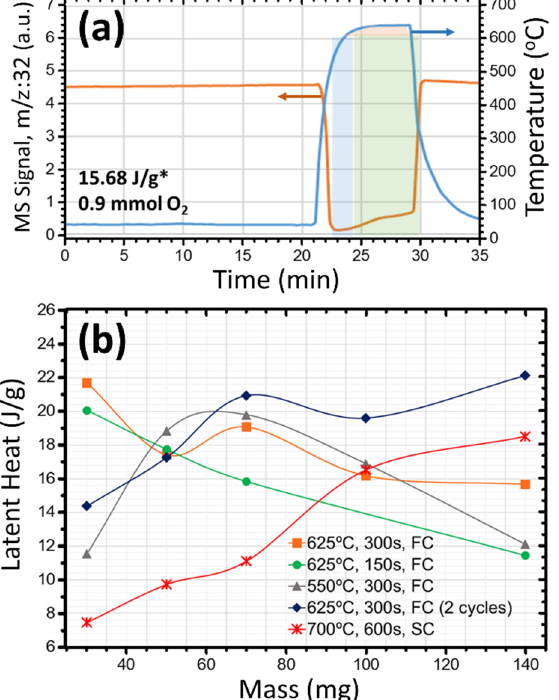
Figure 4. ( a ) TPO-MS for V oxidized at 625 °C for 5 min using ~10 °C s − 1 and ~1 °C s − 1 heating and cooling rates, respectively, the total spent O 2 , and the DSC result for a similar product obtained in open tube. ( b ) Value of enthalpy of MIT (metal to insulator) transformation indicative of the VO 2 yield, for different masses of vanadium subjected to different treatments of oxidation with end of slow (SC) or fast cooling (FC).